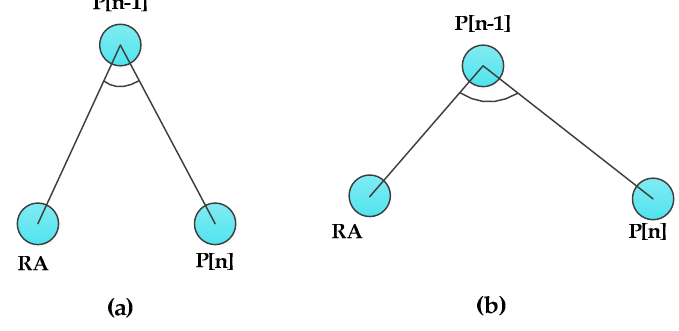
Figure 3. ( a ) Acute and ( b ) obtuse DAMST angles.